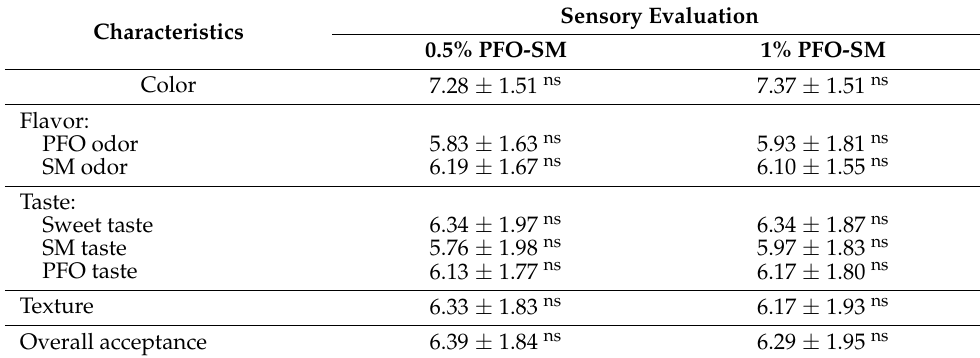
Table 3. Sensory acceptance test conducted in the subjects with respect to 0.5% and 1% ( v / v ) PFO-SM drinks ( n = 100 each) using a 9-point hedonic scale. Data are expressed as mean ± SD values. Characteristics